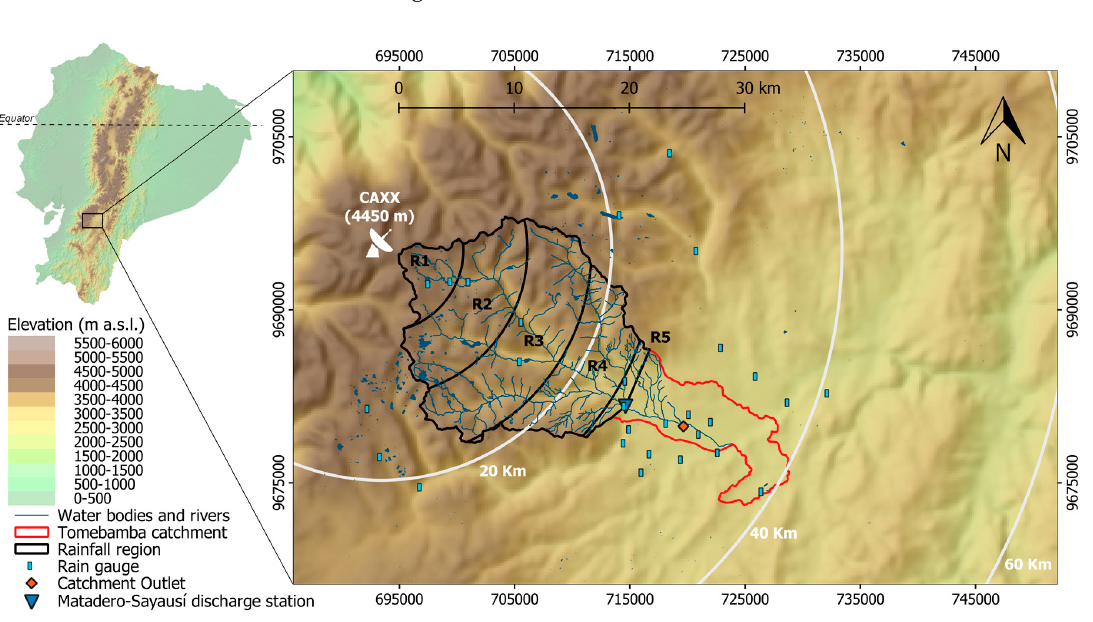
Figure 1. The Tomebamba catchment and delimitation of five rainfall regions at the Matadero-Sayausí discharge station.